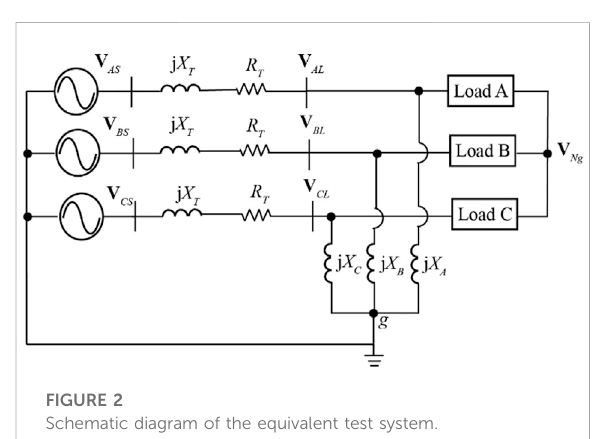
FIGURE 3 Exhaustive search